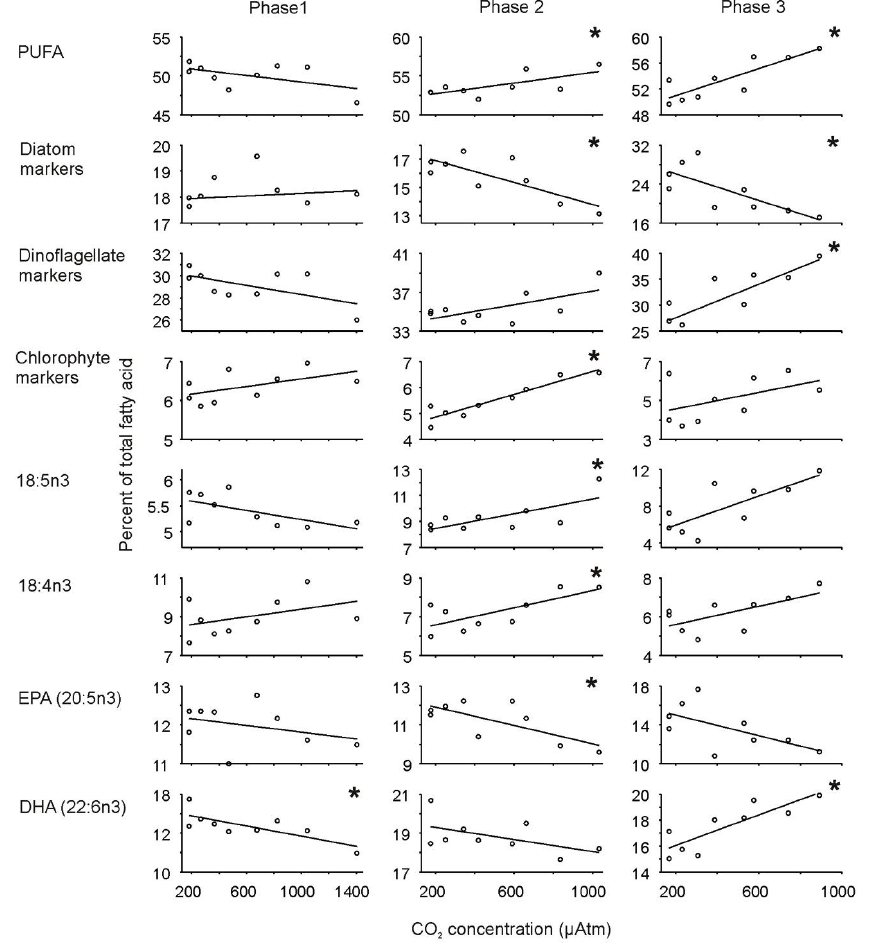
Figure 3 2 Fig. 3. Relationship between proportions of different fatty acid markers (%) and CO 2 level (µ atm) in different phases of the experiment. Proportion of different fatty acids markers and CO 2 levels were averaged over the time period of the three phases: Phase 1=day –4 to 12, Phase 2=day 13 to 21, Phase 3=day 22 to end. linear regressions were fitted to each data set. Asterisks (*) mark those relationships for which the linear regression analysis was statistically significant ( p < 0 . 05, see Table